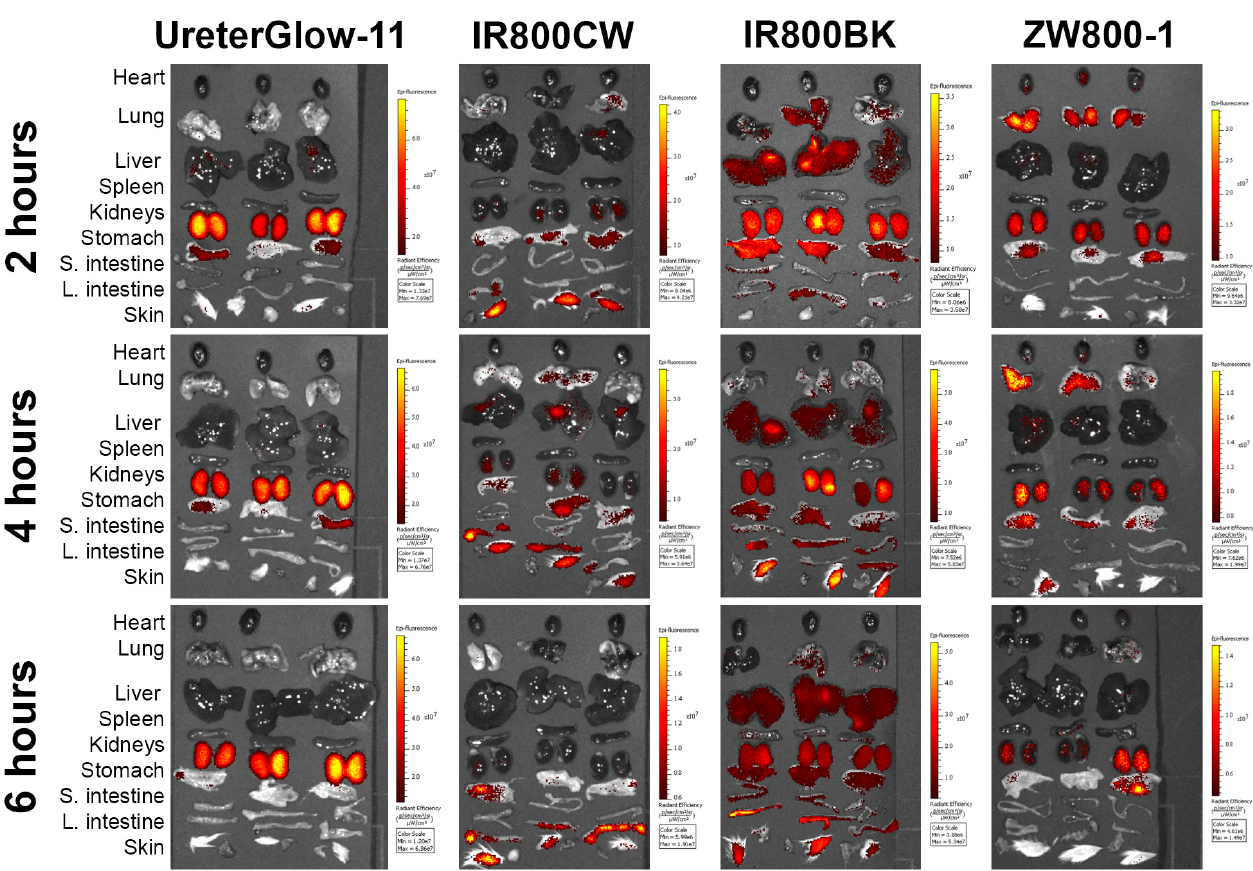
Figure 4. Comparison of in vivo biodistribution of UreterGlow-11 and other NIR ureter imaging dyes/conjugates. Mice Table 1. Photo-physical properties of NIR dyes used for fluorescence-guided surgeries and new were administered 10 nmol of various conjugates ( n = 3 per time point per conjugate) via tail vein injection. After varying PEGylated probes. times, mice were euthanized, their organs were removed, fluorescence intensity was imaged.